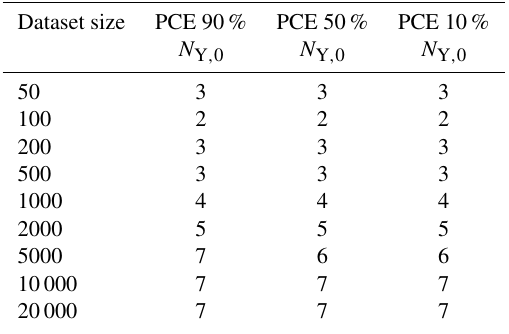
Table A1. Employed polynomial degree of the three PCE models (90%, 50%, and 10% lifetime) as function of training-dataset size. Dataset